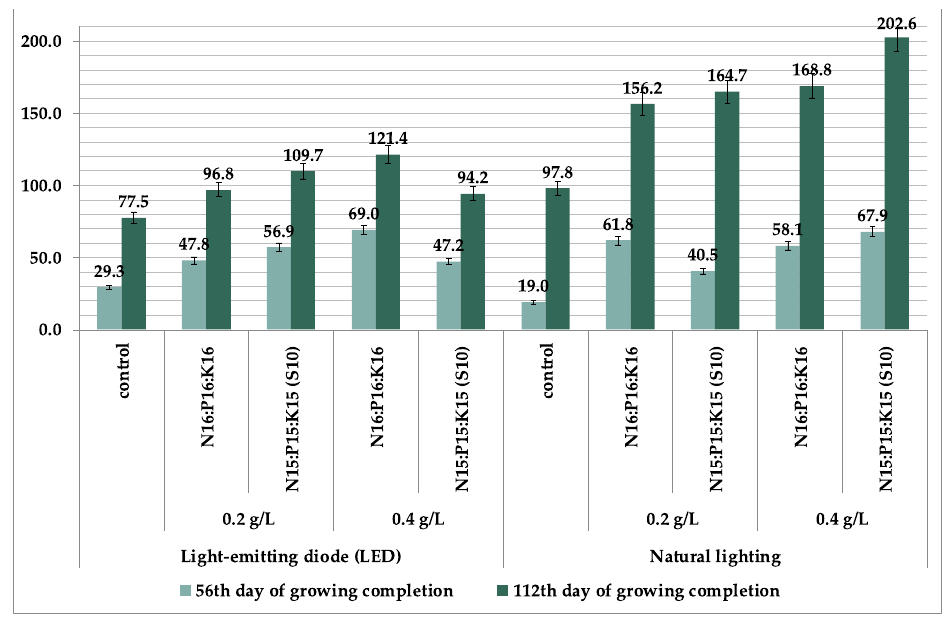
Figure 4. Ex vitro development indexes of highbush blueberry ( Vaccinium corymbosum L.) plants on the 56th and 112th days of growing completion.